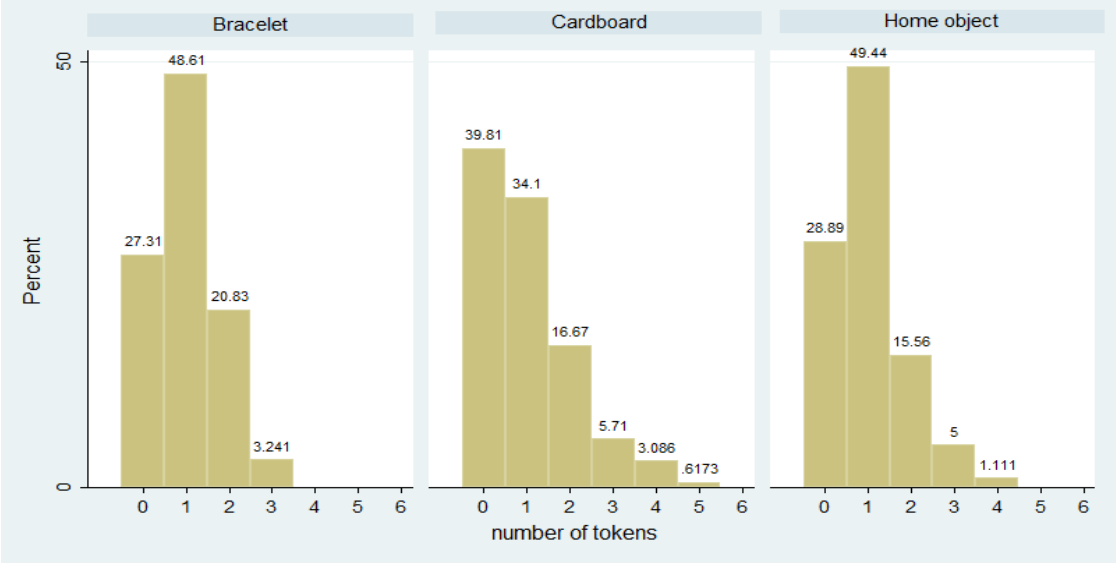
Figure 2. Four scenarios for the tokens.